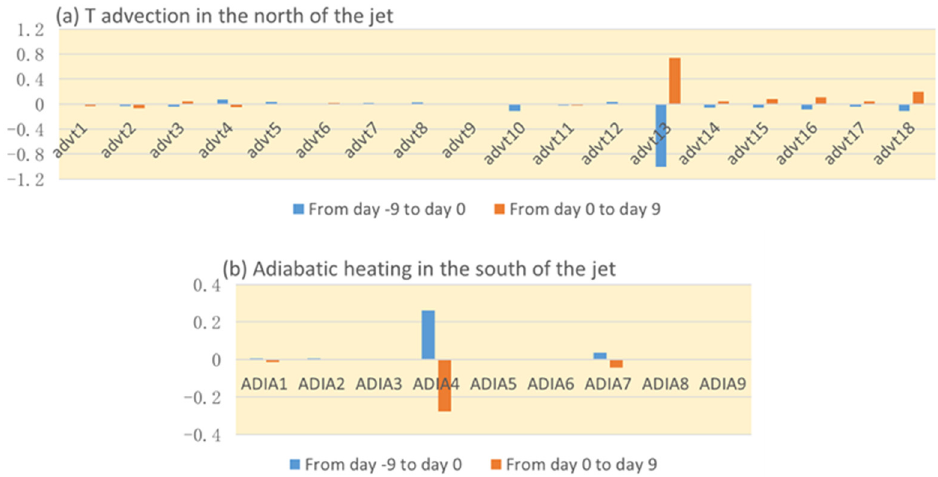
Figure 8. The 18 terms of the intraseasonal temperature advection based on Equation (4) in the north of the jet exit ( a ), and the 9 terms of the intraseasonal adiabatic heating based on Equation (5) in the south of the jet exit ( b ) integrated from the surface to 300 hPa. Unit: °C/d.